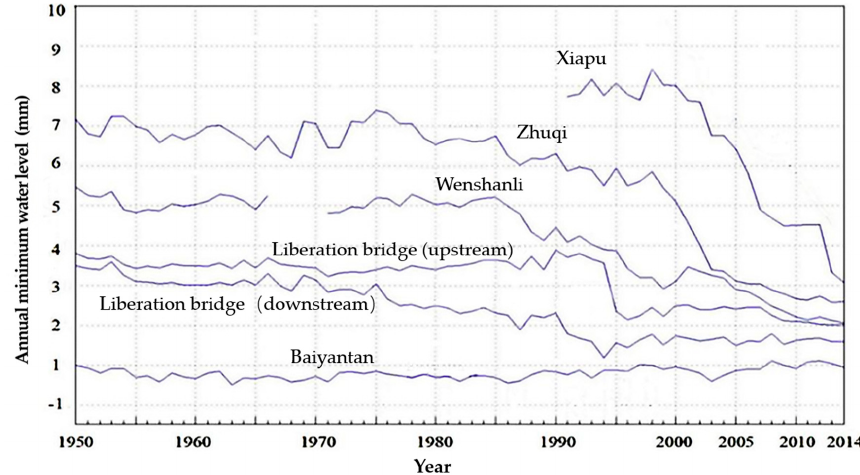
Figure 10. The variation of the lowest water level along the lower reach of the Min